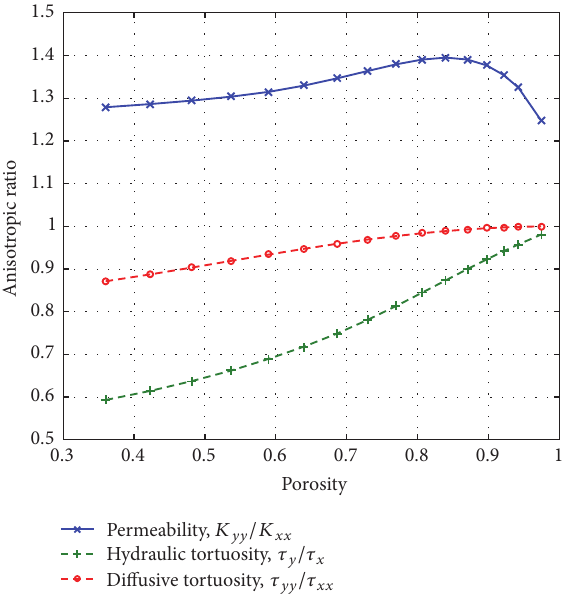
Figure 10: Anisotropic ratios in staggered-array of squares. For all porosities, the anisotropic ratios for hydraulic and diffusive tortuosity are less than one, indicating that the hydraulic flow and passive diffusive transport are more tortuous in the 𝑥 direction than in the 𝑦 direction. The hydraulic flow is more permeable in the 𝑦